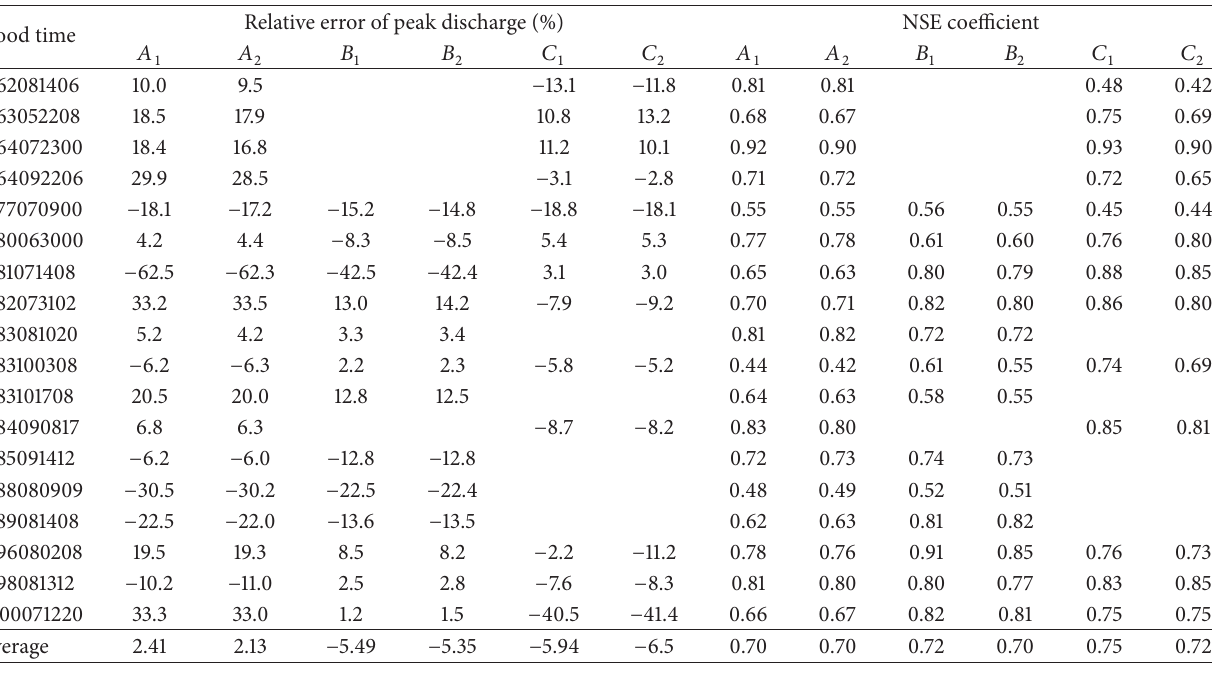
Table 7: Comparison results of the nested catchment.